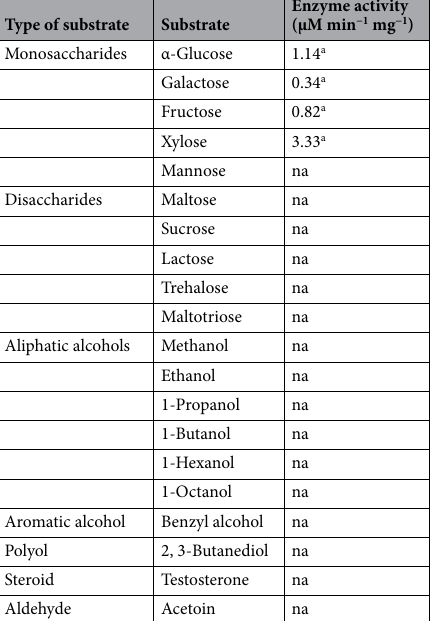
Table 3. Substrates used in screening for oxidation reaction of BPSS2242. The reaction mixture contained 20 mM Tris–HCl (pH 8.0), 500 µM NAD(P) + and various concentrations of substrate (0.1–100 mM). na no activity. a NAD + was used as a cofactor.